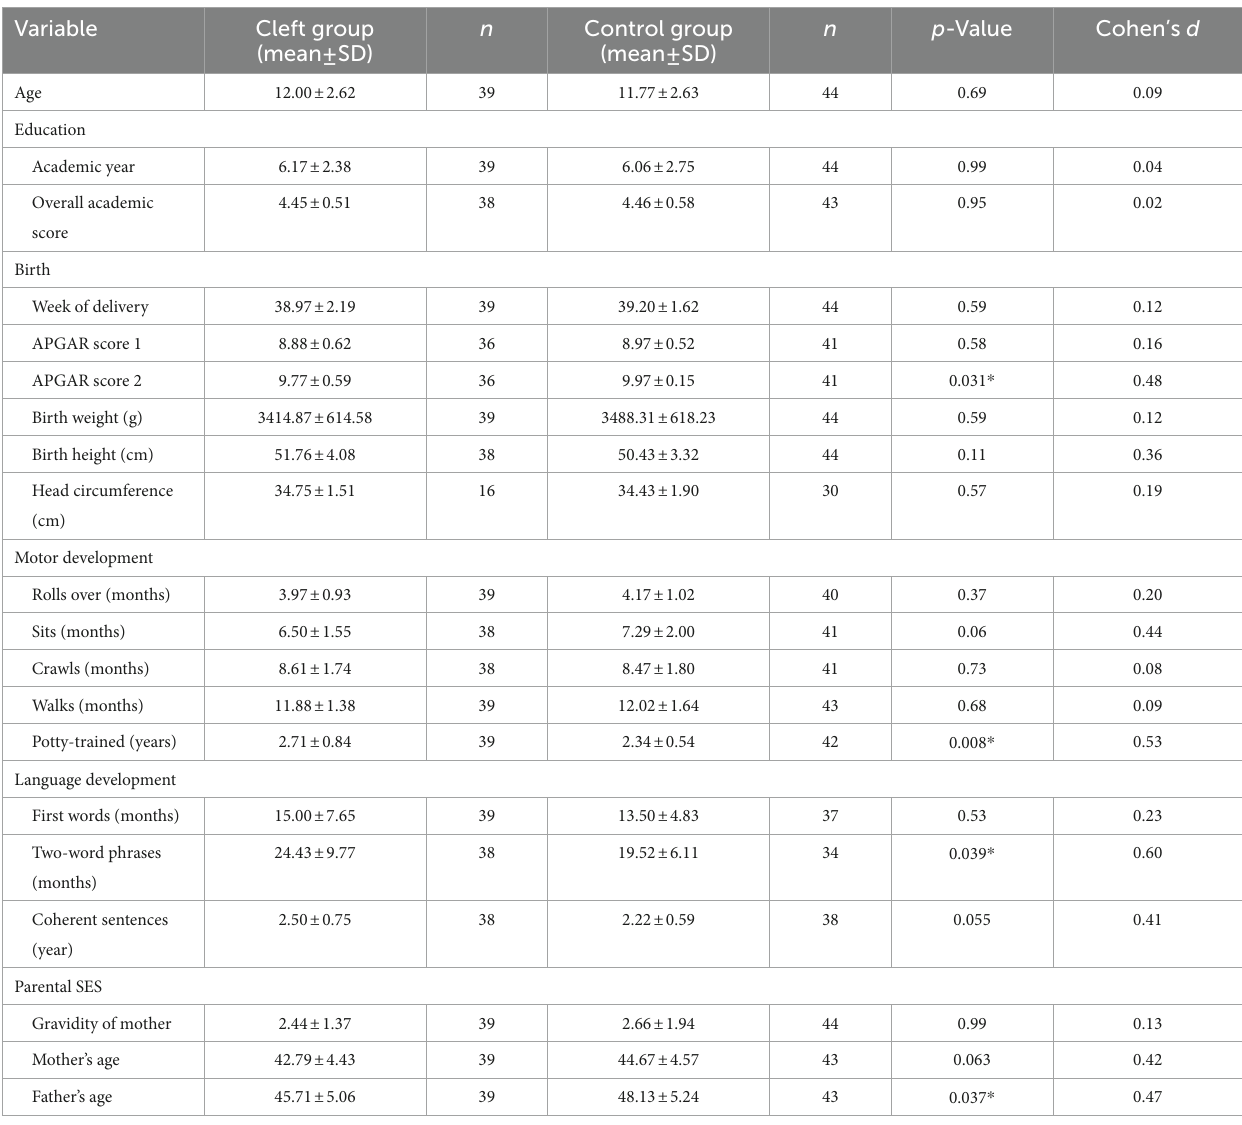
TABLE 4 Demographic data of the study